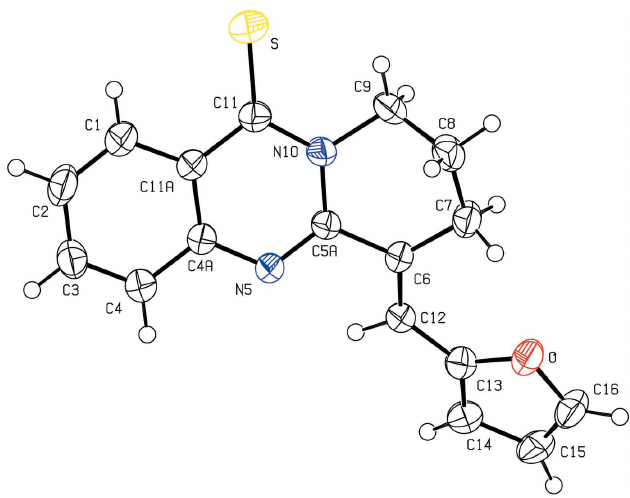
Figure 1 The molecular structure of title compound with the atom labelling. Displacement ellipsoids are drawn at the 50% probability